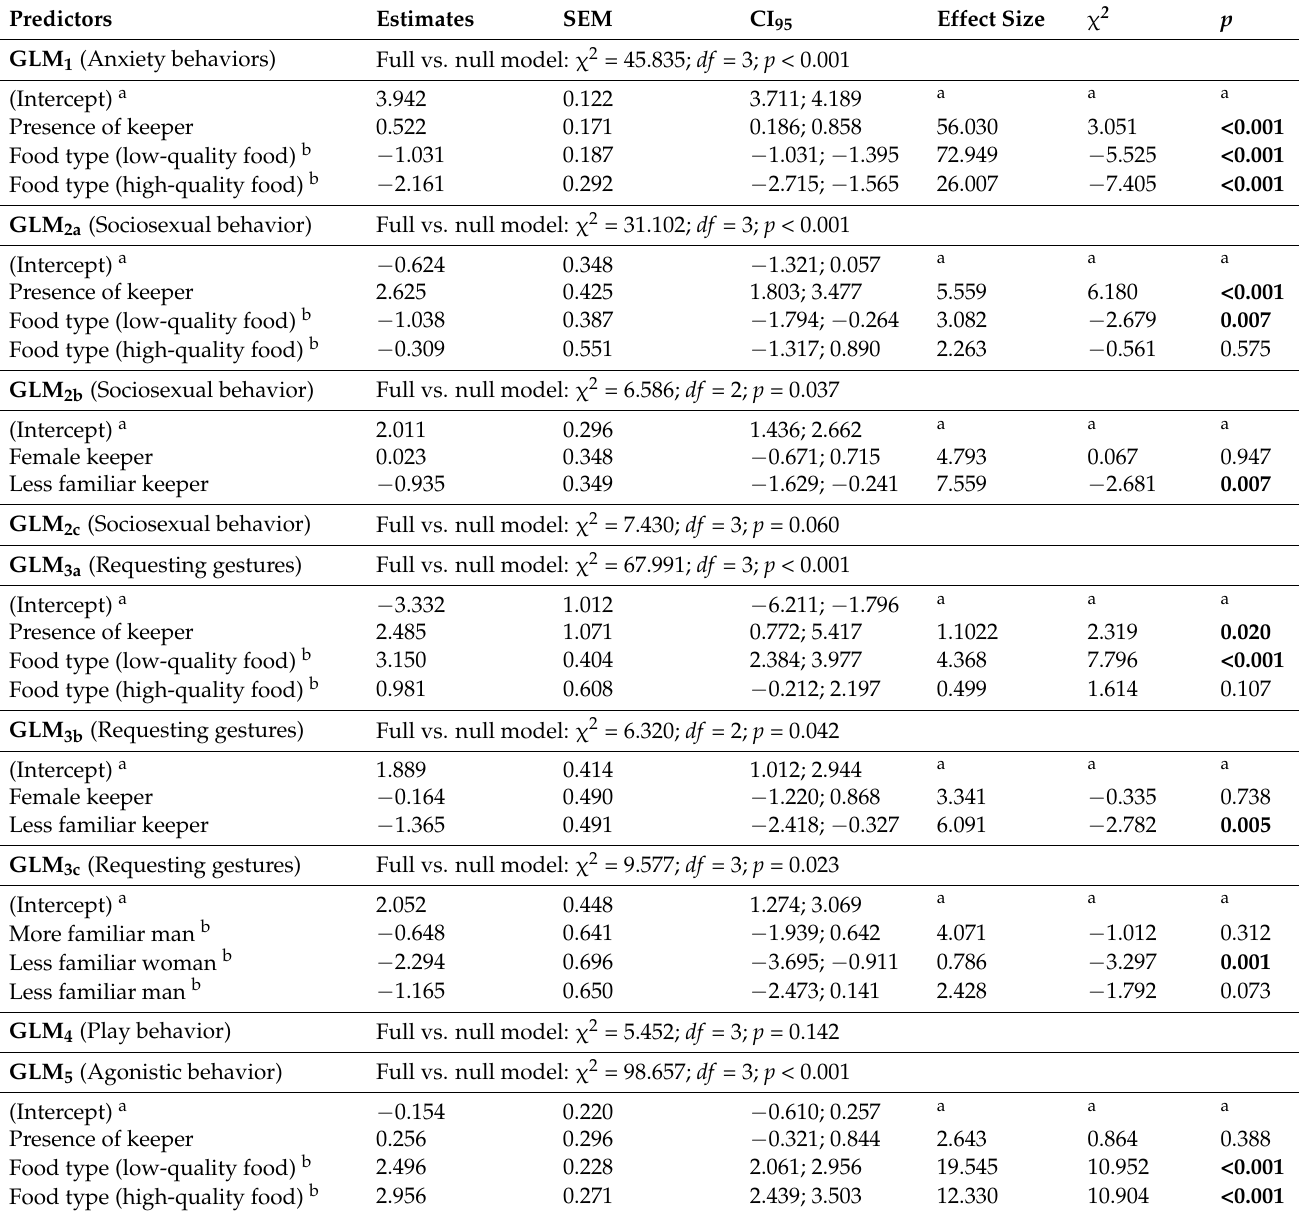
Table 1. Full results on the effect of the keeper’s presence, the presence and type of food, the keeper/bonobo familiarity and the keeper identity on bonobos’